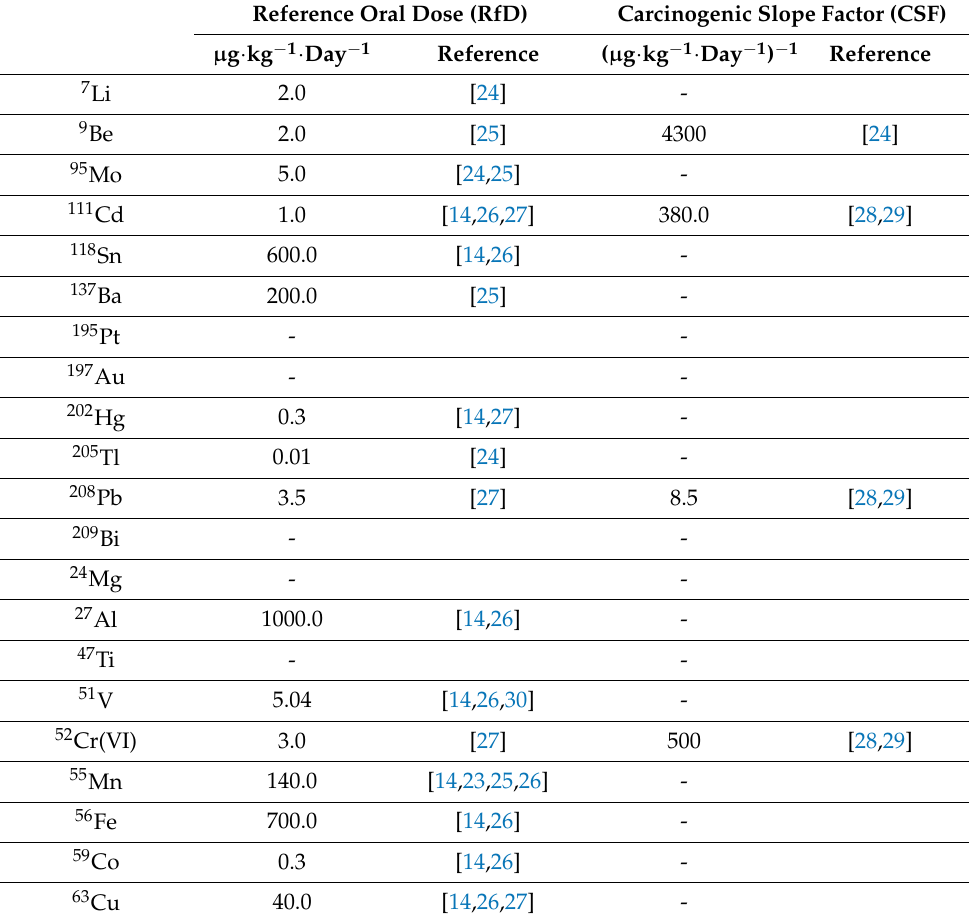
Table 5. Reference oral dose (RfD) and carcinogenic slope factor (CSF) values for toxic and potentially toxic